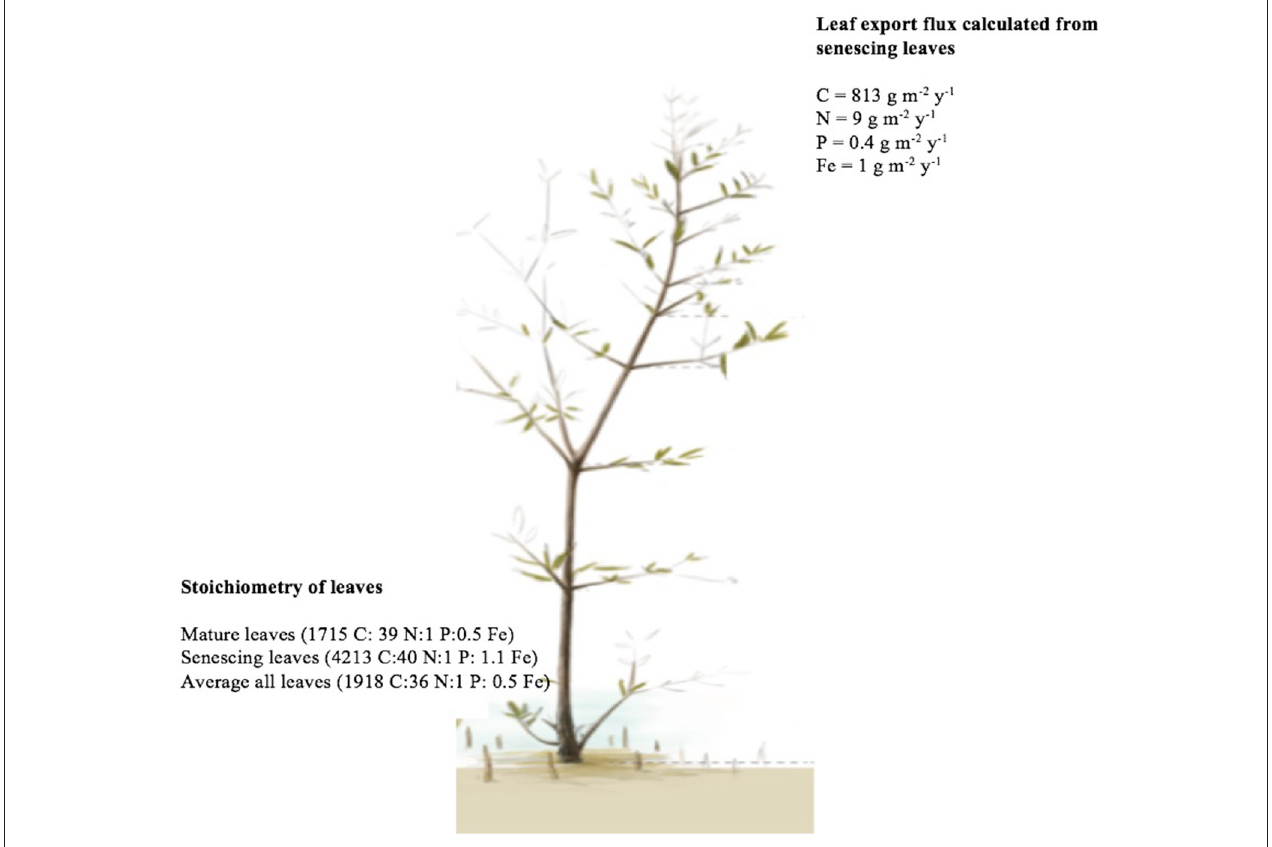
FIGURE 7 | The average nutrient input from senescing leaves in Central Red Sea mangroves and the stoichiometric ratios of the leaf export flux (mature, senescing and average of all ages).